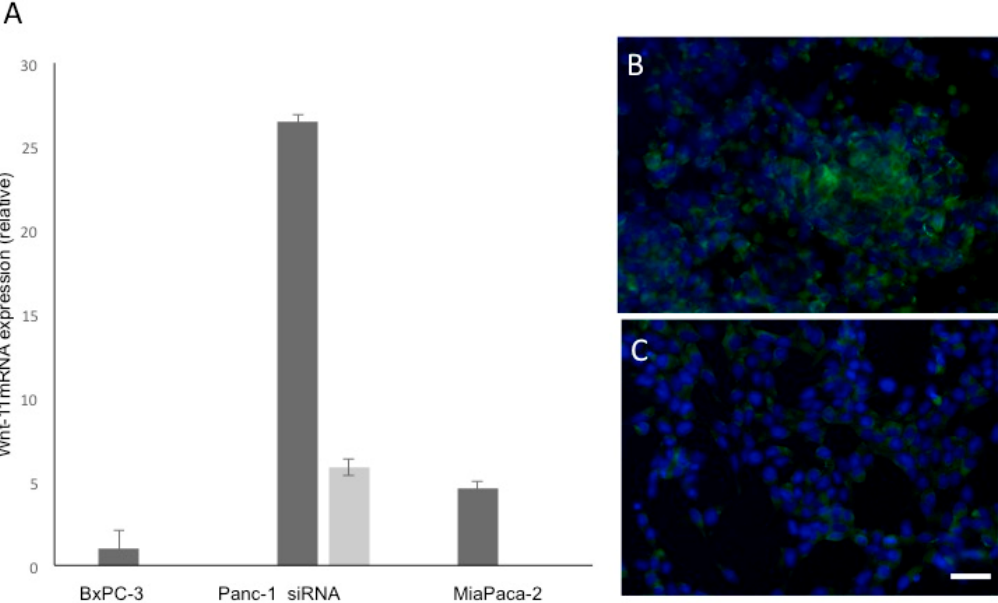
Figure 1. Wnt-11 mRNA relative expression profile in Bx-PC3, Panc-1 and MiaPaca-2 cells, and Wnt-11 siRNA on Panc-1 cells. ( A ) Real-time PCR result of Wnt-11 relative mRNA expression. Data are plotted as fold-di ff erences relative to the Bx-PC3 cell Wnt-11 mRNA expression level after normalising with housekeeping gene (RPII) level. Panc-1 cells express the highest amount of Wnt-11 mRNA (folds more than Bx–PC3; n = 6; p < 0.01) among three pancreatic cancer cell lines and Wnt-11 siRNA reduces the expression 4.52-fold (light grey bar; n = 6; p = 0.011). All data were analysed as means ± standard errors. Statistical significance was determined using Student’s t -test or ANOVA with Newman–Keuls post-hoc analysis were used, as appropriate. ( B , C ) Immunostaining for Wnt-11 (green) and To-Pro (blue) in Panc-1 cells transfected with Wnt-11siRNA. ( B ) Control. ( C ) Wnt-11 siRNA for 48 hours. Scale bar, 20 µ m (applicable to both panels).